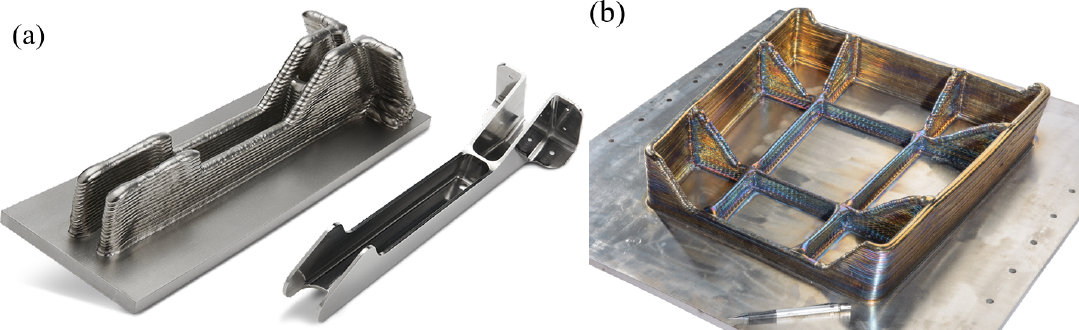
Figure 6. Titanium components manufactured by wire additive processes: ( a ) Boeing 787 structural component manufactured by Norsk Titanium’s Rapid Plasma Deposition TM process; and ( b ) Bombardier external landing gear assembly manufactured by the WAAM process at Cranfield University. Images in ( a , b ) reproduced with permission from Norsk Titanium [64] and Cranfield University [66],